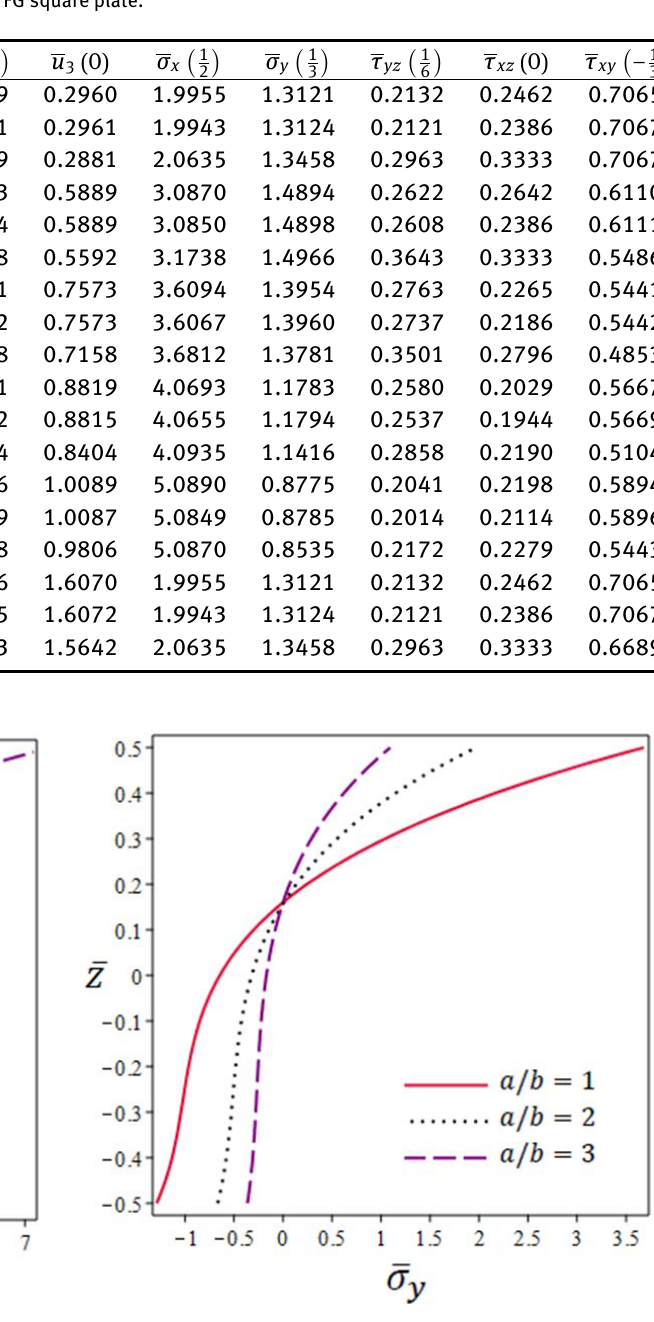
Figure 4: The axial stress σ y across the thickness of a FG plate with k = 2 and a / h = 10